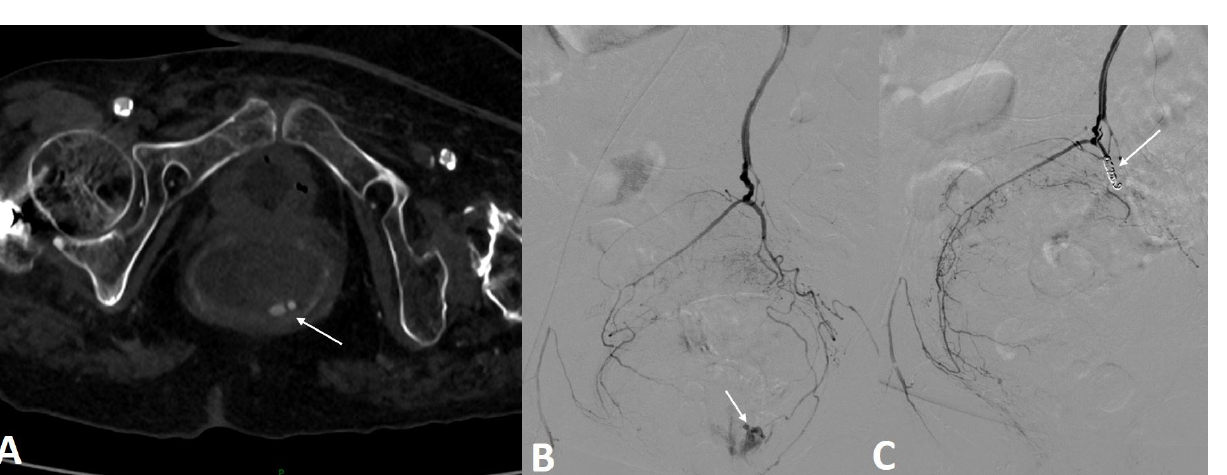
Figure 2. A 56-year-old male was referred to the emergency room for profuse hematemesis. Gas- troscopy confirmed the presence of antral bleeding, with no possibility of stopping the bleeding. ( A ) Axial section CT scan injected at the arterial phase, confirming the active contrast extravasation. ( B ) Axial section abdominal CT scan injected at portal phase showing an increase of the leak of iodine contrast. ( C ) Angiography performed within the superior mesenteric artery using a Cobra probe showed an active contrast leak from a branch of the right gastroepiploic artery. ( D ) After embolization with three coils, the angiographic control showed a clear stop of the bleeding.